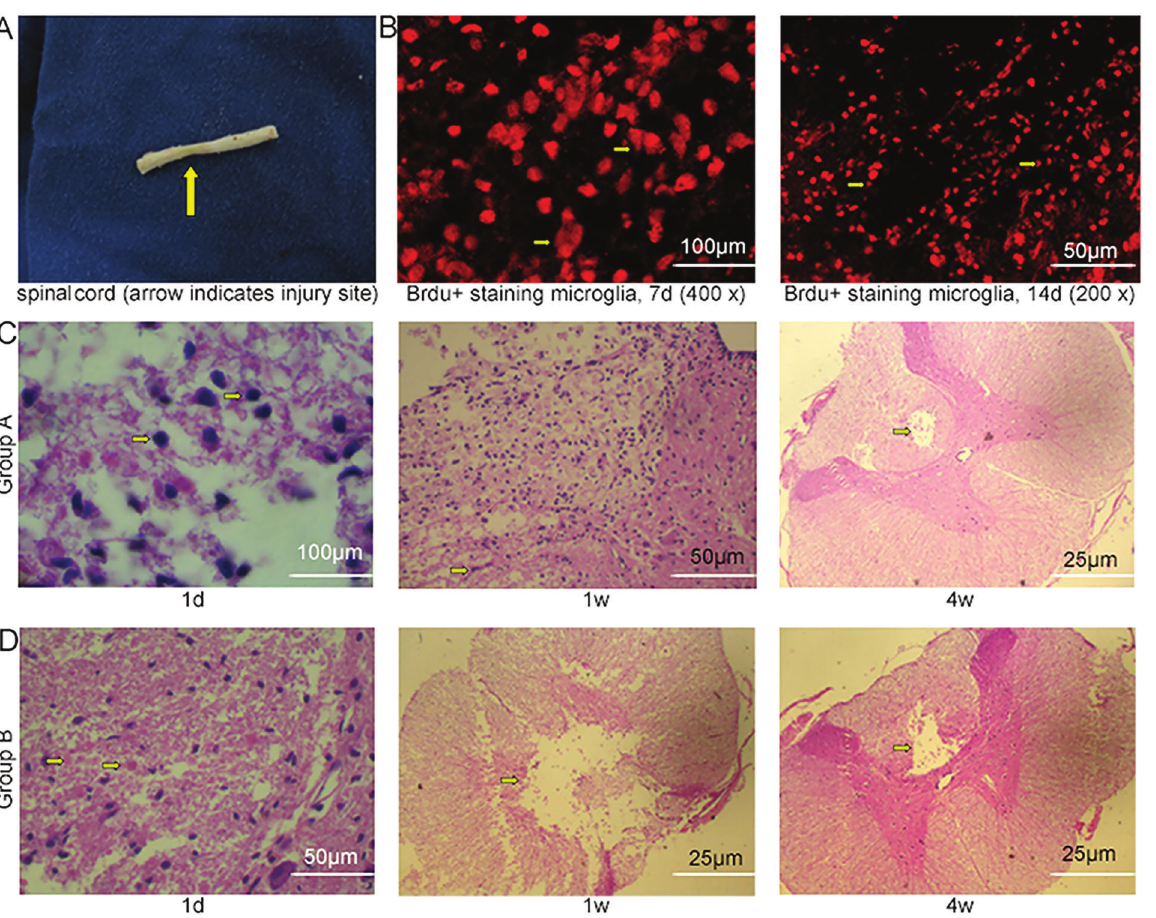
Figure 4. Tracing of transplanted microglial cells and histological staining of the injured spinal cord. A , The injured spinal cord. B , BrdU- labelled microglia after transplantation (7d, 400 (cid:1) , bar: 100 m m; 14d, 200 (cid:1) , 50 m m). C and D , H&E staining of the injured spinal cord in the microglial cell transplantation group A and saline injection group B at 1 day (d), and 1 and 4 weeks (w). Bars: C : 100 m m, 50 m m, 25 m m, respectively; D : 50 m m, 25 m m, 25 m m, respectively.